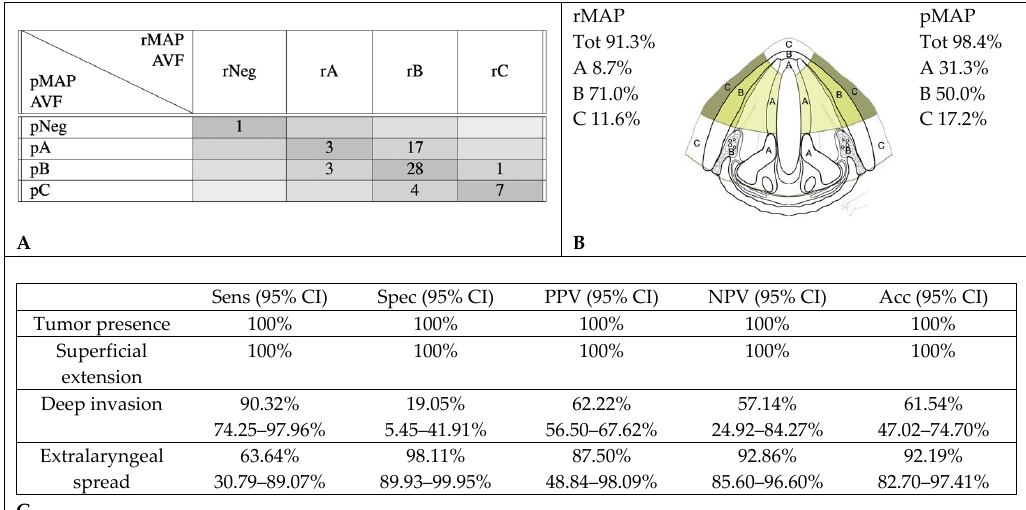
Figure 3. Accuracy in radiological assessment of anterior vocal fold (AVF) involvement. ( A ) Graphical representation of concordance between CT and histopathology in anterior vocal fold assessment. ( B ) Percentage of cancer involvement of anterior vocal fold in rMAP and pMAP. ( C ) Sensitivity (Sens), specificity (Spec), positive predictive value (PPV), negative predictive value (NPV) and accuracy (Acc) of CT in anterior vocal fold. CI: confidence interval, rMAP: radiological glottic map and pMAP: histopathological glottic map. Cancers 2019 , 11 , x